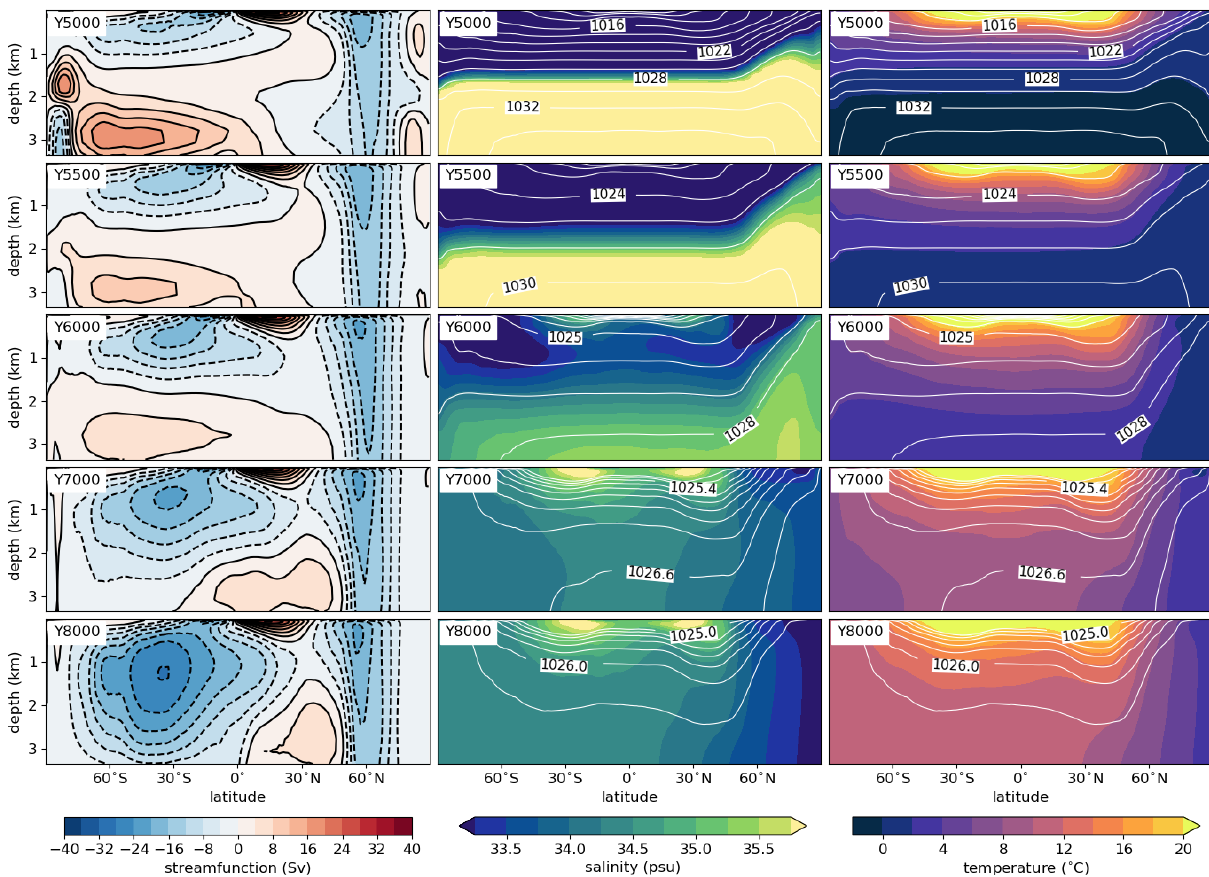
Figure 5. Zonally averaged streamfunction (left), salinity (middle) and potential temperature (right) for five representative times during the strong warming scenario SC-CONST, depicted by 30-year averages around the given time stamp. Positive MOC values represent a clockwise circulation. Figure settings and color intervals are the same as in Fig. 2. Contours of potential density are shown in intervals of 2kgm − 3 in the two upper rows, in intervals of 1kgm − 3 in the third row and in intervals of 0.2kgm − 3 for densities above 1025kgm − 3 in the two lower